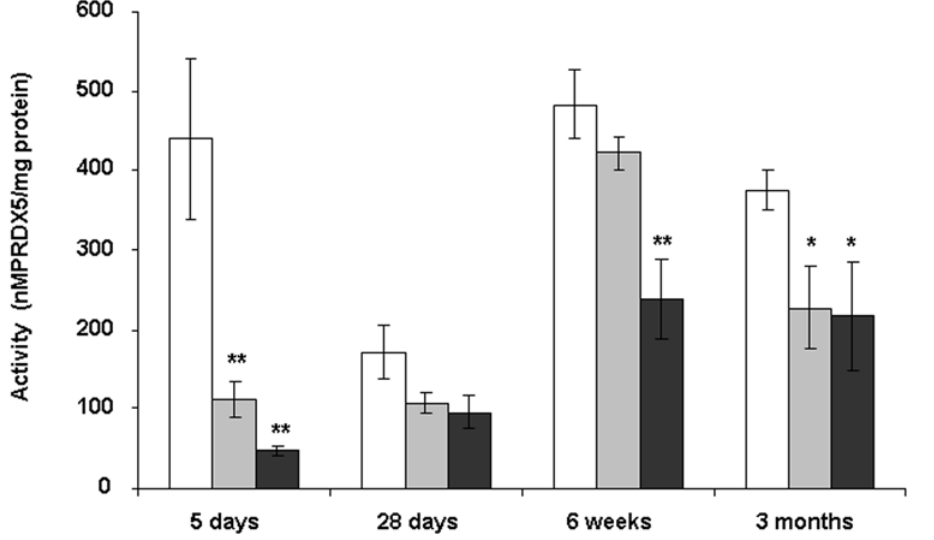
Figure 6. Peroxiredoxin activity in liver from C (white bars), LP (grey bars), LPT (black bars). Results are expressed as means 6 SEM; n=4– 5 independent experiments. *p , 0.05, ** p , 0.01 vs C;